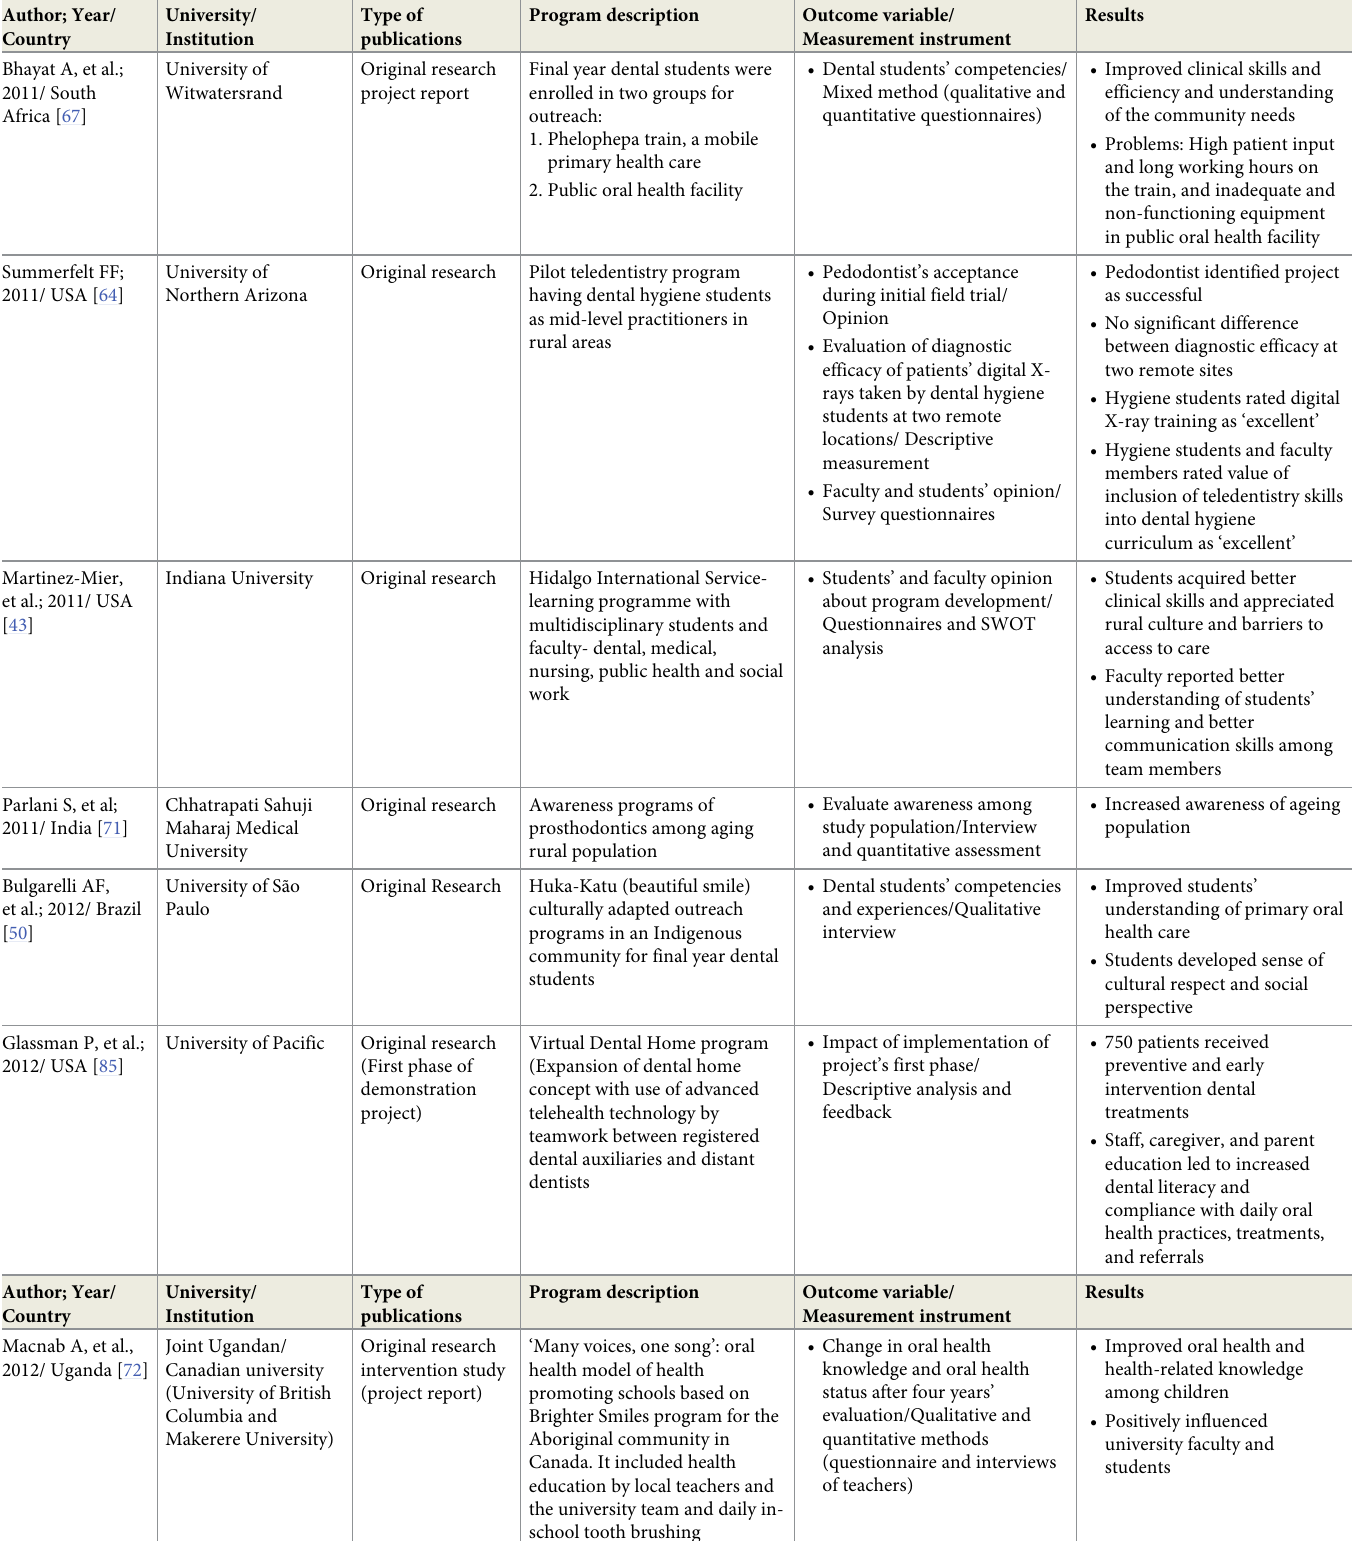
Table 5. Summary of published research articles identified in the scoping review (2011